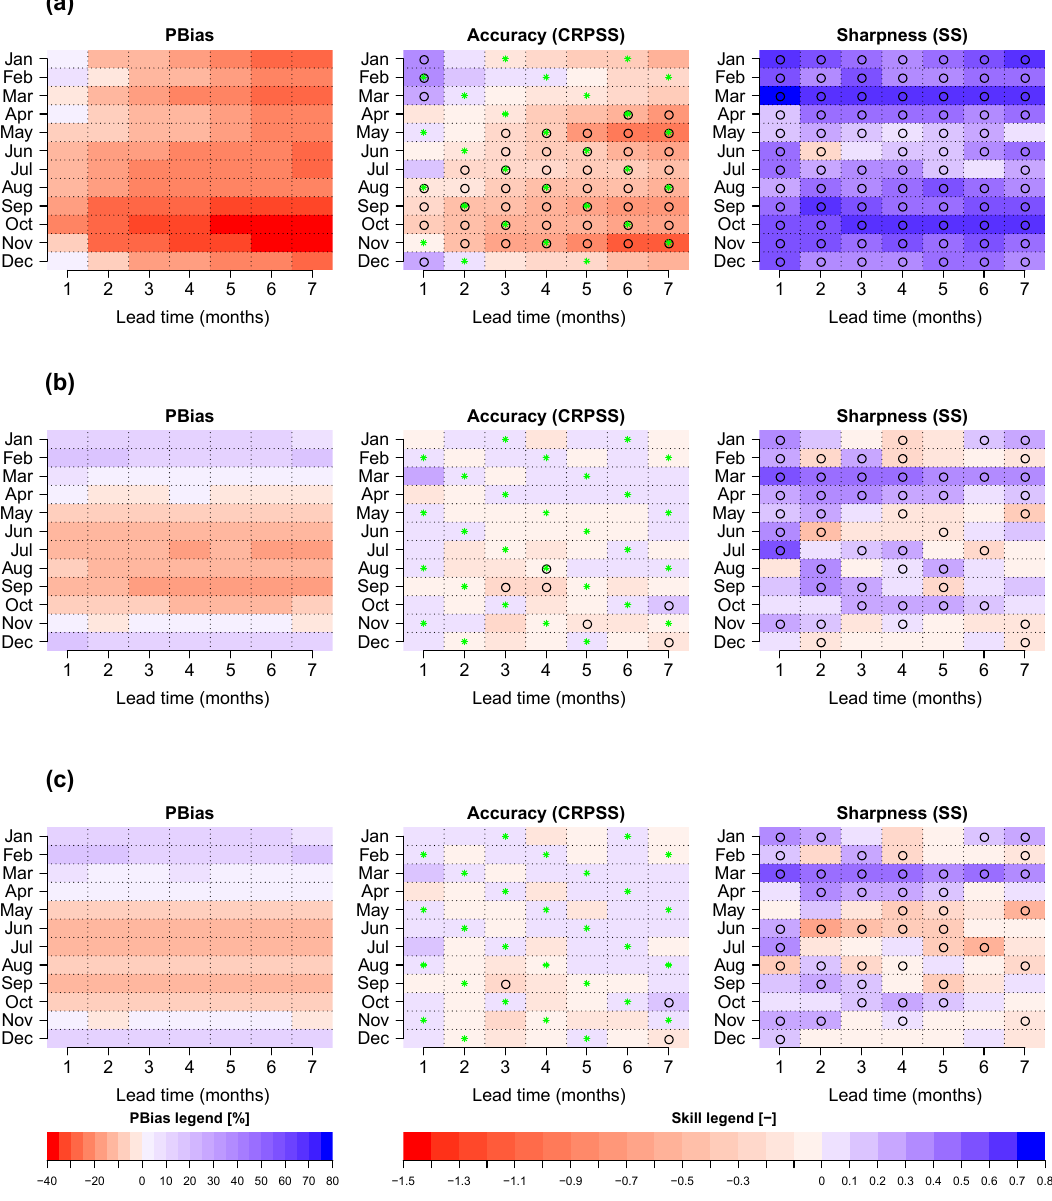
Figure 5. PBias and skill in terms of accuracy and sharpness of monthly means of daily streamflow of raw and preprocessed forecasts at station 82. Streamflow forecasts are generated using (a) raw meteorological forecasts and preprocessed meteorological forecasts with the (b) linear scaling/delta change (LS) and (c) quantile mapping (QM) methods. The y axis represents the target month, and the x axis represents the different lead times at which target months are forecasted. Values in the blue range show a positive bias/skill and values in red a negative bias/skill. Circles represent the cases where the distribution of the accuracy and/or sharpness for ESP differs from that of the ECMWF System 4-generated forecasts at a 5% significance level using the WMW test. Green crosses represent the months/lead times for which the ensemble size is